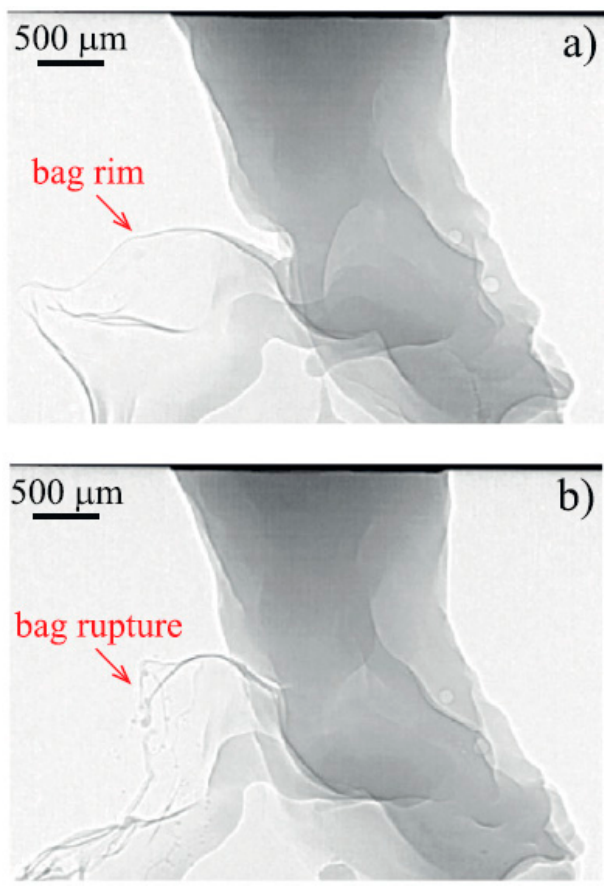
Figure 15. Deformation of annular liquid sheet with droplet entrainment in a two-fluid coaxial atomizer studied with broadband X-ray radiography [74]. Subfigures ( a ) and ( b ) show consecutive frames separated by 1 ms time interval.